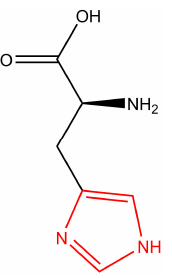
Figure 8. The amino acid histidine with the imidazole group (red) as part of the side chain.